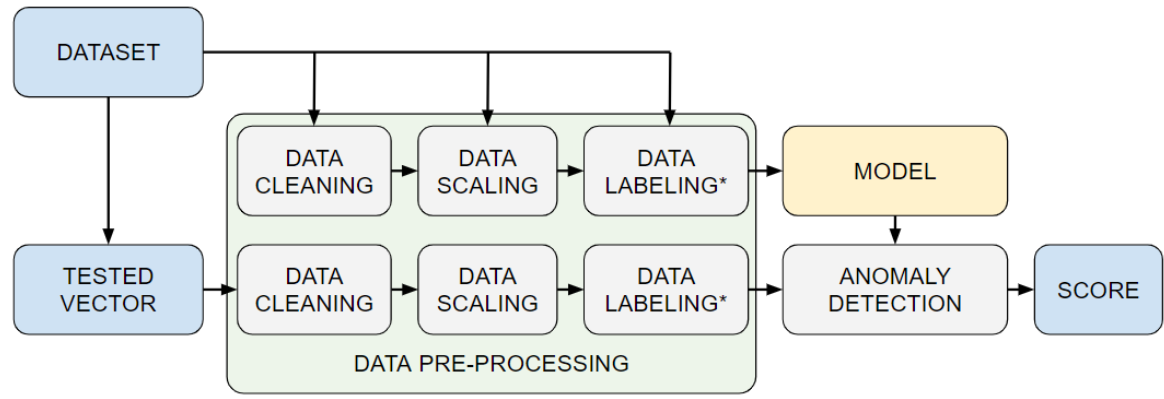
Figure 5. Block diagram representing the data flow in the presented approach.